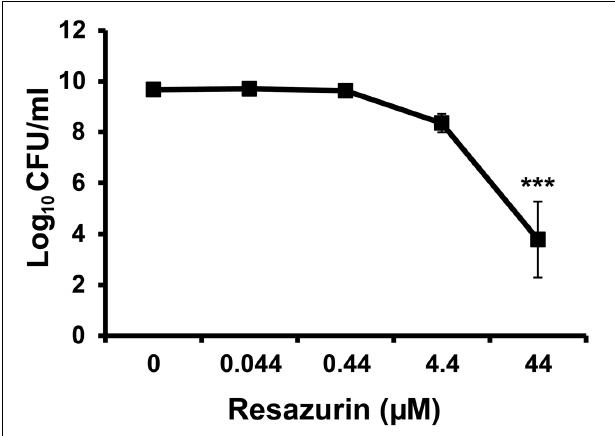
FIGURE 2 | Resazurin has an antimicrobial effect on F. tularensis LVS. Bacteria were cultivated in tryptic soy broth supplemented with 0.1% cysteine HCl (TSBc) in the presence or absence of resazurin at the designated concentrations for 24h. Cultures were then diluted and plated to determine the number of viable F. tularensis LVS bacteria 24h post inoculation. Data shown are mean ± s.e.m. from three individual experiments. The limit of detection was 100CFU per ml. Statistically significant differences in growth post-inoculation were determined by One-Way ANOVA followed by Dunnett’s post-hoc test ( ∗∗∗ p < 0 . 001 compared to 0 µ M